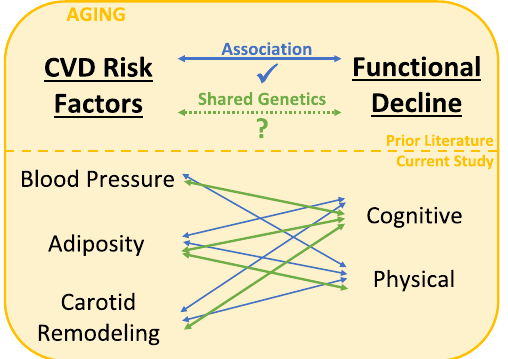
Figure 2. Summary Diagram of the Current Study’s Purpose and Findings. Infographic of the study purpose (dashed green line, top portion of figure) and findings (bottom portion of figure), including highlighting trait pairs with significant phenotypic (blue lines) or genetic (green lines)